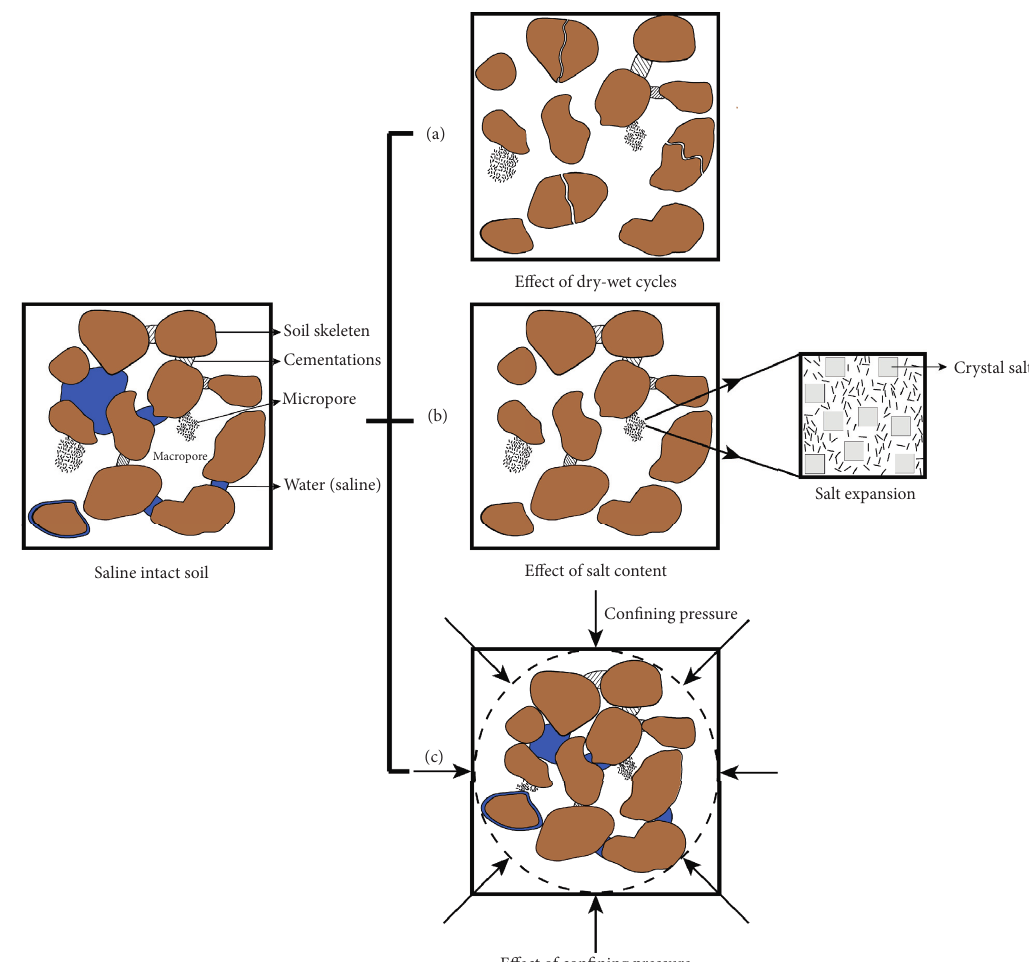
Figure 4: Schematic diagram for the influence of dry-wet, salt content, and confining pressure on soil